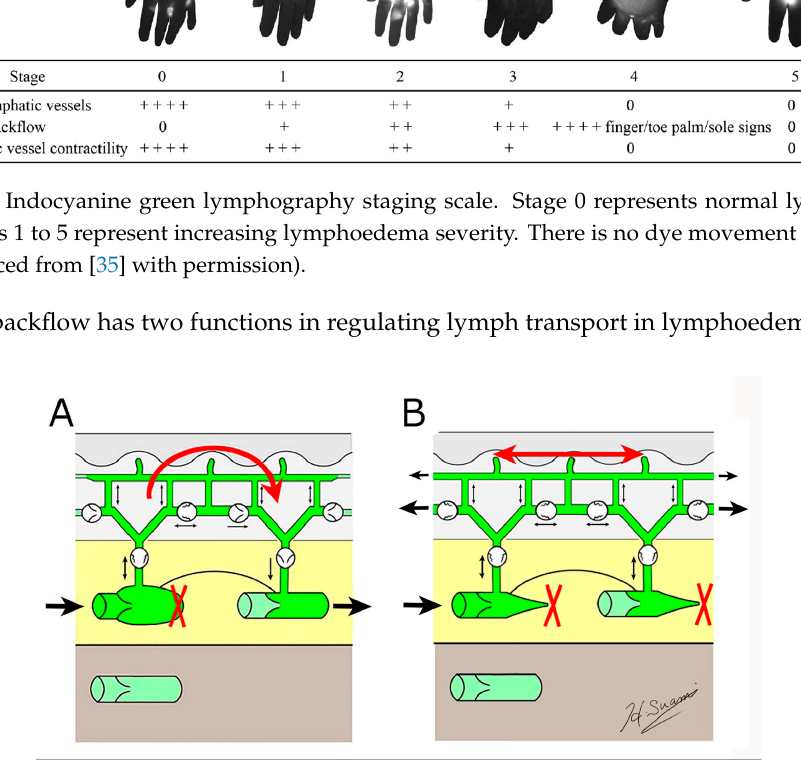
Figure 5. Schematic diagrams showing the structural changes in lymphoedema. ( A ) dermal backflow forms a bridge between obstructed and patent lymphatic vessels, and ( B ) dermal backflow serves as a substitute route to transport lymph fluid following the obstruction of the superficial collecting vessels through fibrosis. (Reproduced with permission of Hiroo Suami).